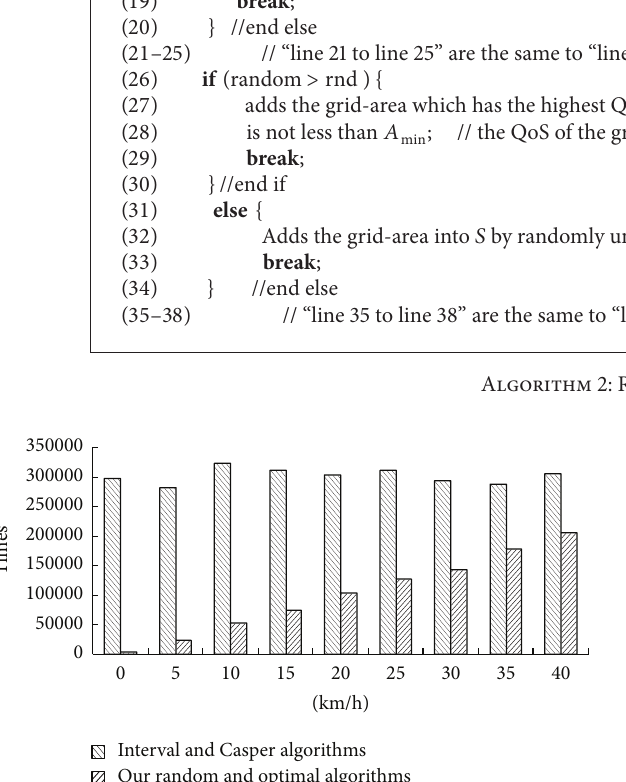
Interval algorithm Casper algorithm Figure 5: The square measure of